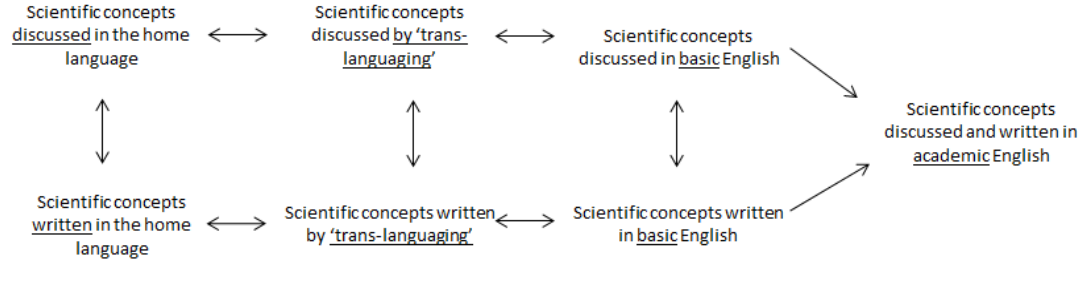
Figure 1 : Using the dominant language to enhance epistemological access, and subsequently develop scientific and academic